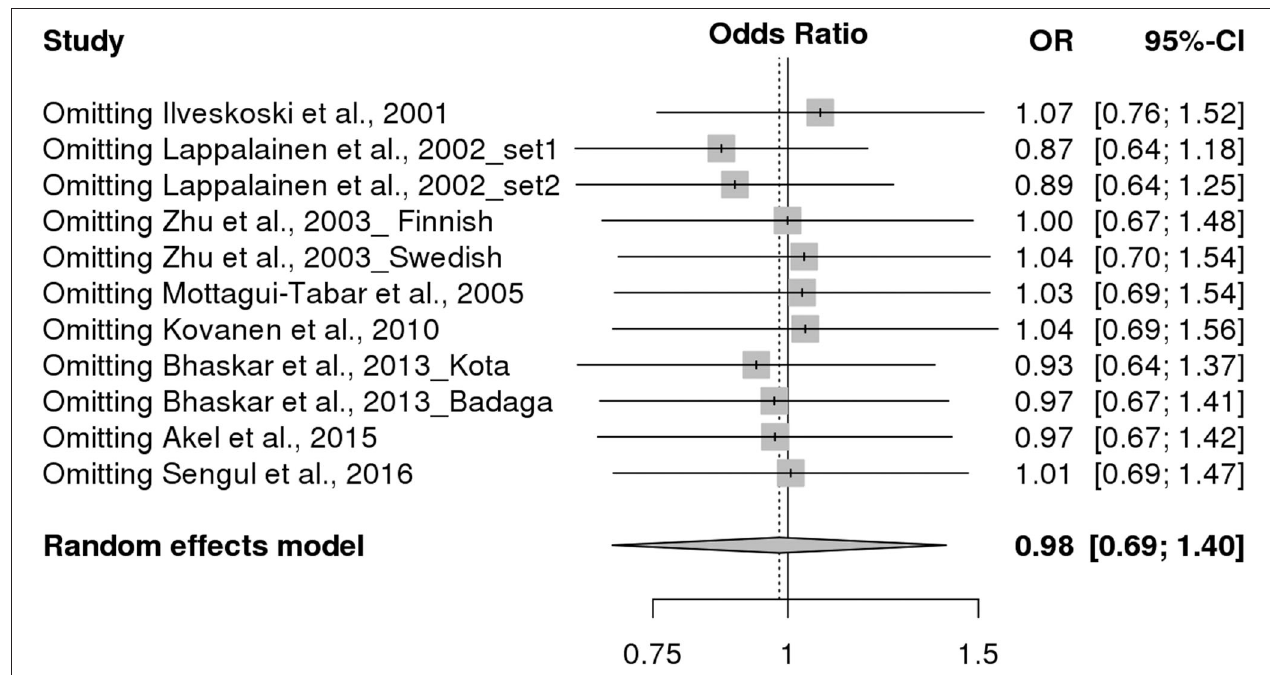
FIGURE 3 | Sensitivity analysis of this